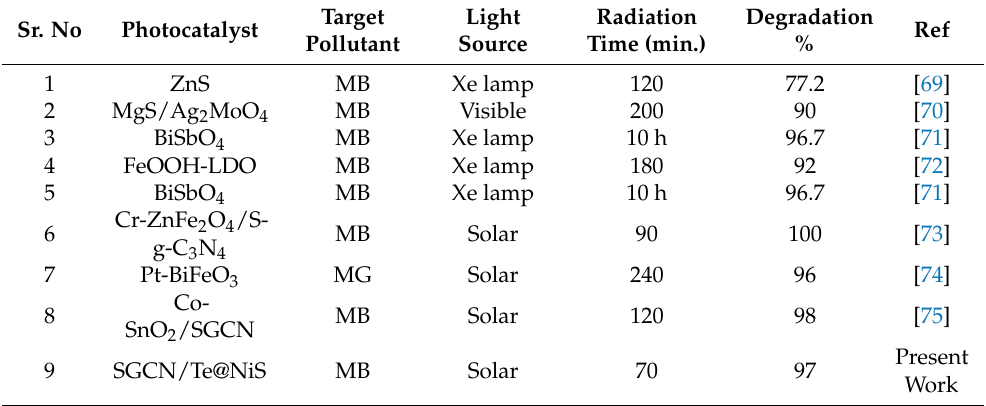
Sr. No Photocatalyst